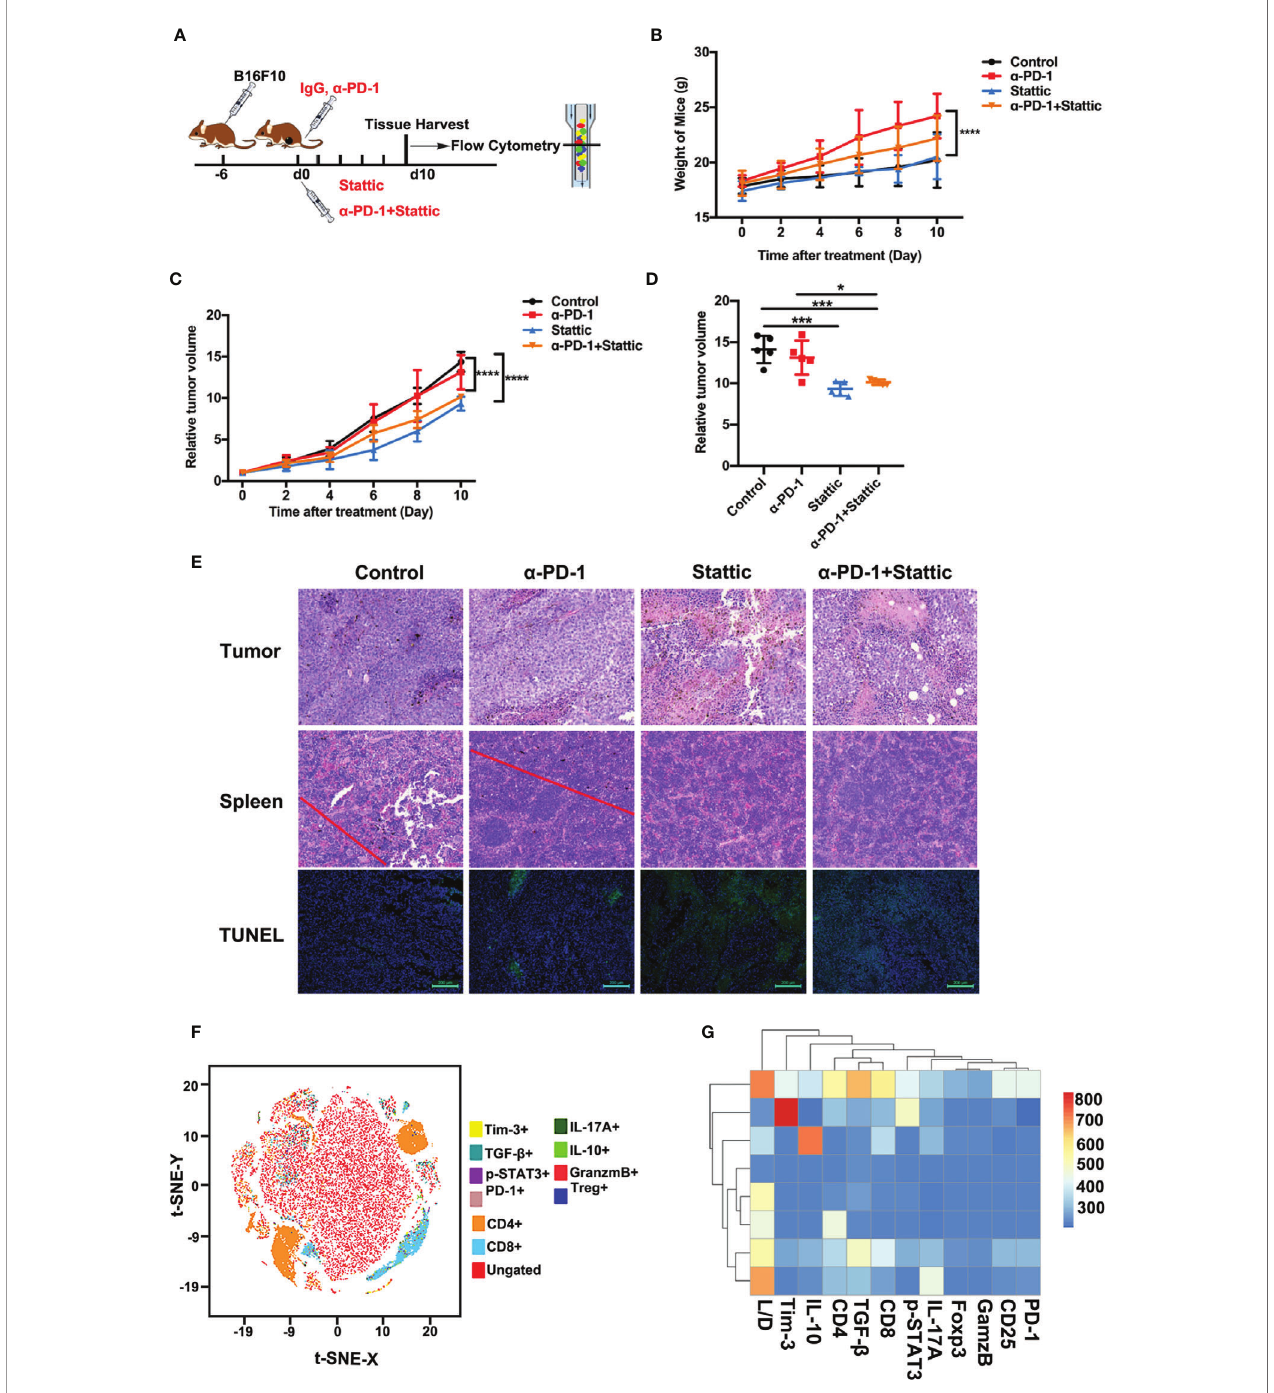
FIGURE 5 | STAT3 inhibitor enhanced the ef fi cacy of anti-PD-1 in a melanoma model. (A) Schematic illustration of different treatments in the melanoma mouse model. (B) Weight curve of B16-F10 tumors from mice administered with different treatments (n=5 ; p < 0.0001). (C) Relative tumor volume curve of B16-F10 tumors after treatment with anti-PD-1 alone, Stattic alone, anti-PD-1 plus Stattic, and IgG isotype control (n=5; p < 0.0001). (D) Relative tumor volume at terminal time of experiments with four different treatments (n=5; p < 0.05; p < 0.001; p < 0.001). (E) Tumor necrosis in tumor sections as indicated by hematoxylin and eosin (H&E) staining. Tumor metastasis to the spleen was assessed by H&E staining. Tumor apoptosis in tumor sections was examined using TUNEL staining. Scale bar = 50 m m or 100 m m. (F) tSNE plots of CD8 + T cells of spleen tissues from B16-F10 tumor-bearing mice. (G) Heat map of the tumor-associated gene signature mapped to the different tumor treatment, representing the spleen tissues and CD8 + T cells subsets from B16-F10 tumor-bearing mice. * p ≤ 0.05, *** p ≤ 0.001,**** p ≤